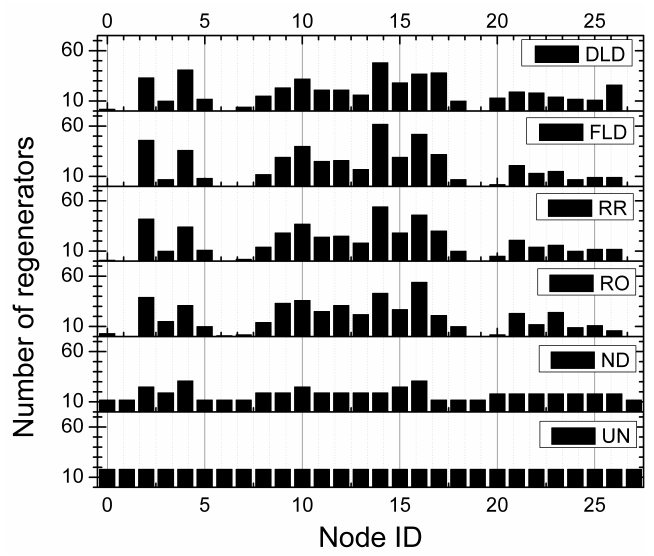
Figure 5. Number of regenerators placed by each considered RP algorithm in each network node of EuroNet assuming the uniform traffic and total amount of 504 regenerators placed in the network.